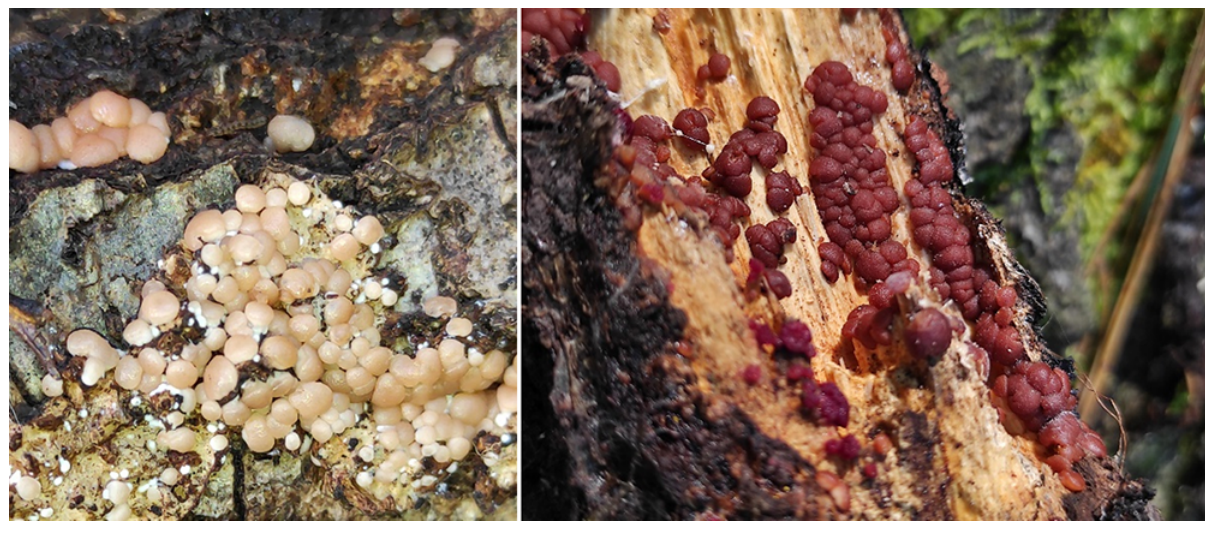
Figure 2 Stromata (young in le panel, mature in right panel) of Hypocrea tremelloides from Kampinos National Park; October 9, 2021. Photography by A.